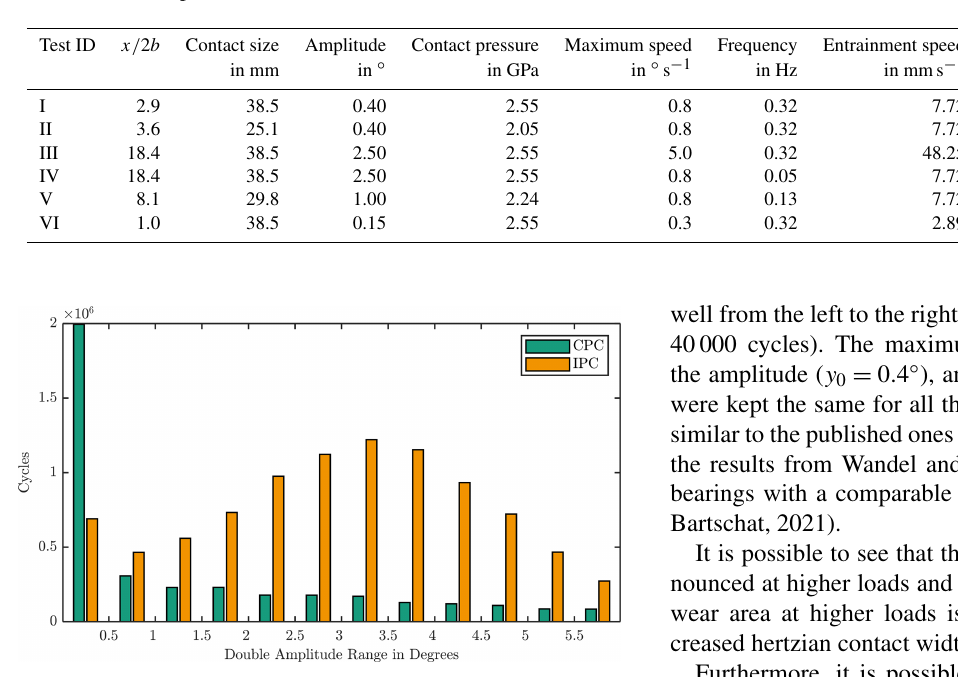
Table 3. Test setup.